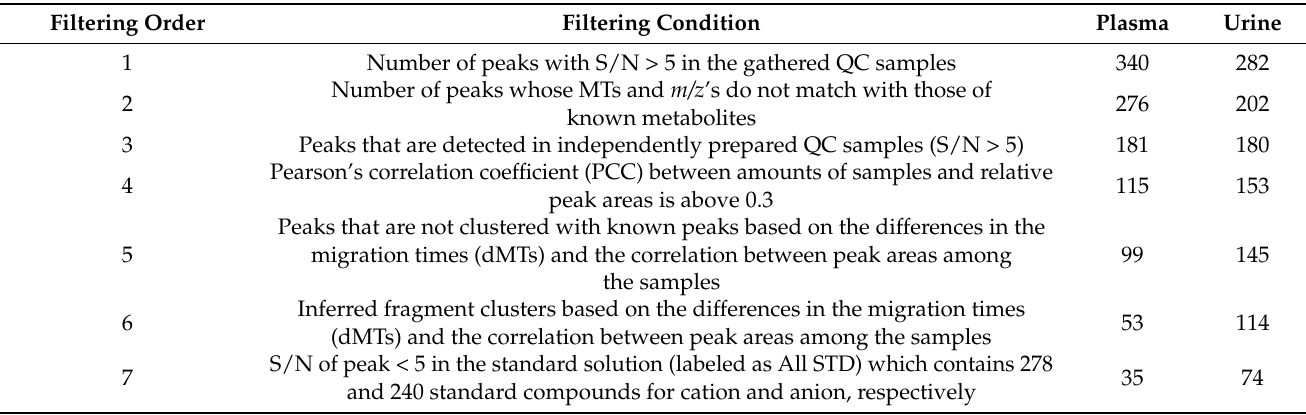
Table 2. Number of reliable uncharacterized peaks detected using seven filtering